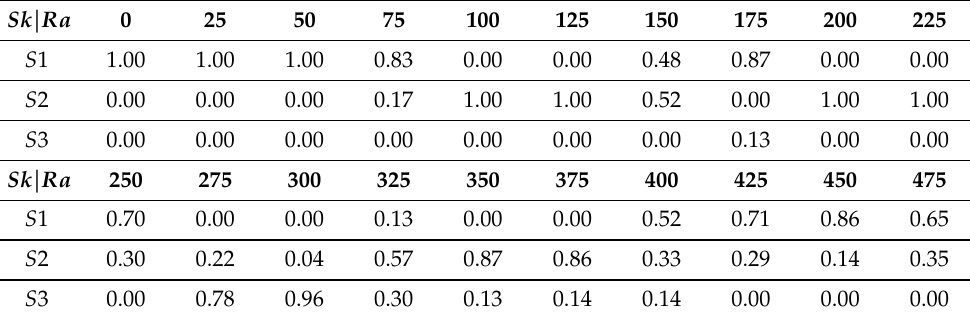
Table 5. Conditional probabilities ˆ P ( Sk | Ra ) of Sk solutions, k = { 1,2,3 } .